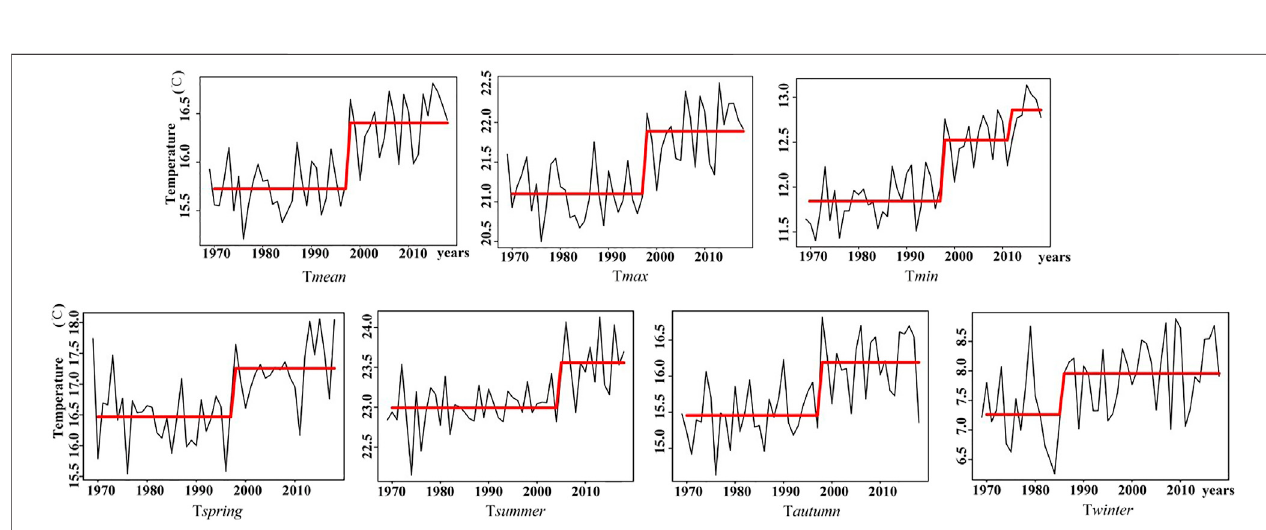
FIGURE 4 | Seasonal variations of NSAT anomalies in Southwest China for the period 1969 – 2018.